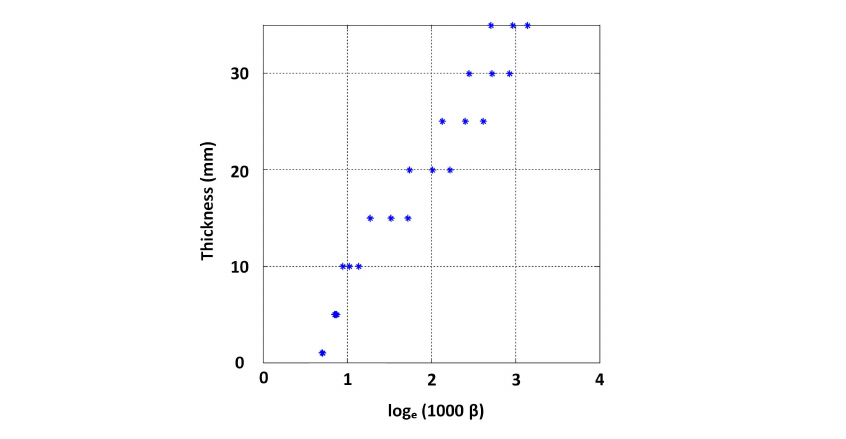
Figure 23. Influence of variation of σ on β reduced by expressing β in the logarithmic